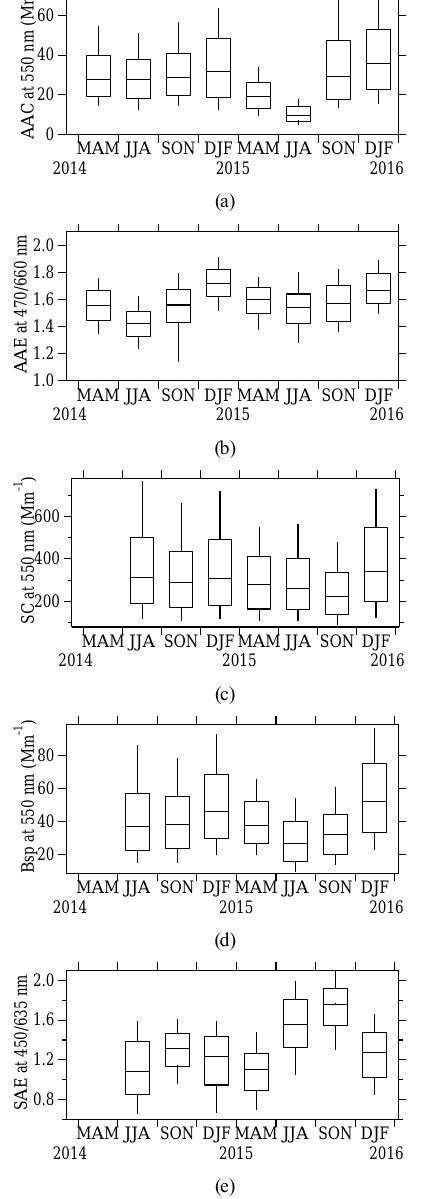
Figure 1. The 10th, 25th, median, 75th and 90th percentiles of 550nm AAC ( a , Mm − 1 ), 470 / 660nm AAE (b) , 550nm SC ( c , Mm − 1 ), 550nm ( d , Mm − 1 ) and 450 / 635nm SAE (e) in each sea- son from March 2014 to February 2016.